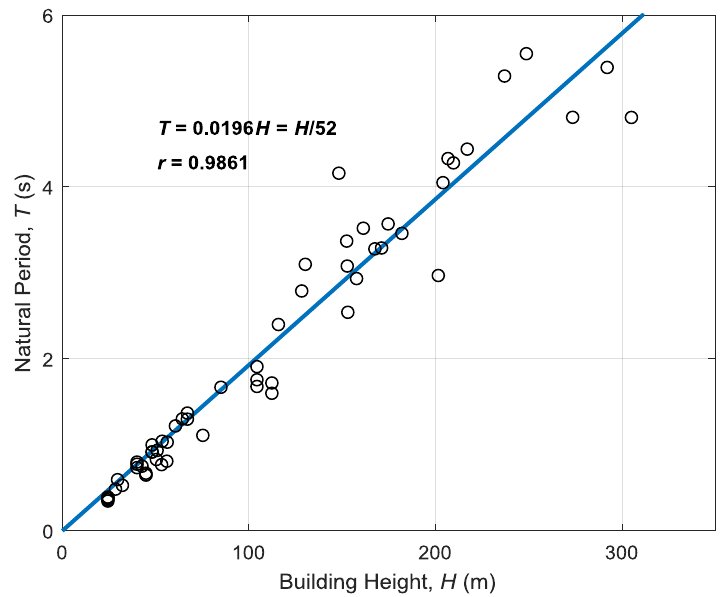
Figure 8. Regression analysis of measured natural period.